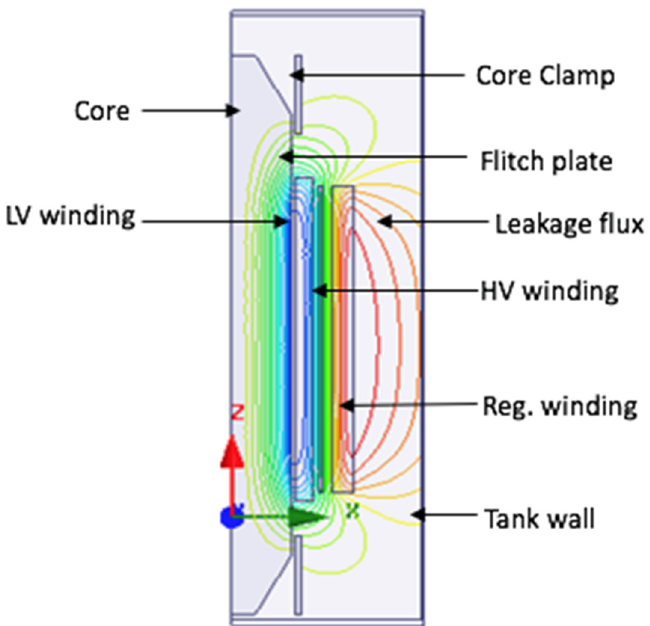
Figure 5. 2D geometry of main parts subjected to leakage flux.